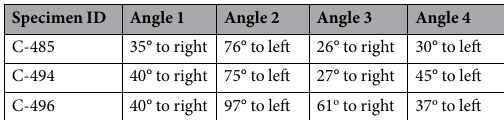
Table 2. Angles of the inflated penis tips of three harbor porpoises. The first angle is relative to the long axis of the penis shaft such that 0° angles parallel to shaft in the cranial direction and the subsequent angles are relative to the preceeding angle. The four angles show marked directional changes in the penis tip (Fig. 3a). Prior to measurement, penises were angled in a coronal plane with the tip facing cranially.